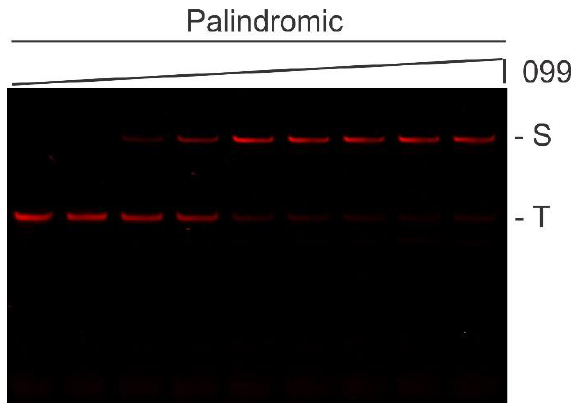
Figure 4. EMSA analysis of TTHB099 binding to its palindromic consensus sequence. Shown is an IR fluorescence image of IRD7-labeled ST2_099 incubated with 0, 0.66, 1.32, 2.64, 5.27, 10.5, 21.1, or 42.2 nM TTHB099 protein. (S) Protein-DNA complex, and (T) uncomplexed DNA. Biolayer interferometry (BLI) was used to characterize TTHB099-consensus DNA interactions.